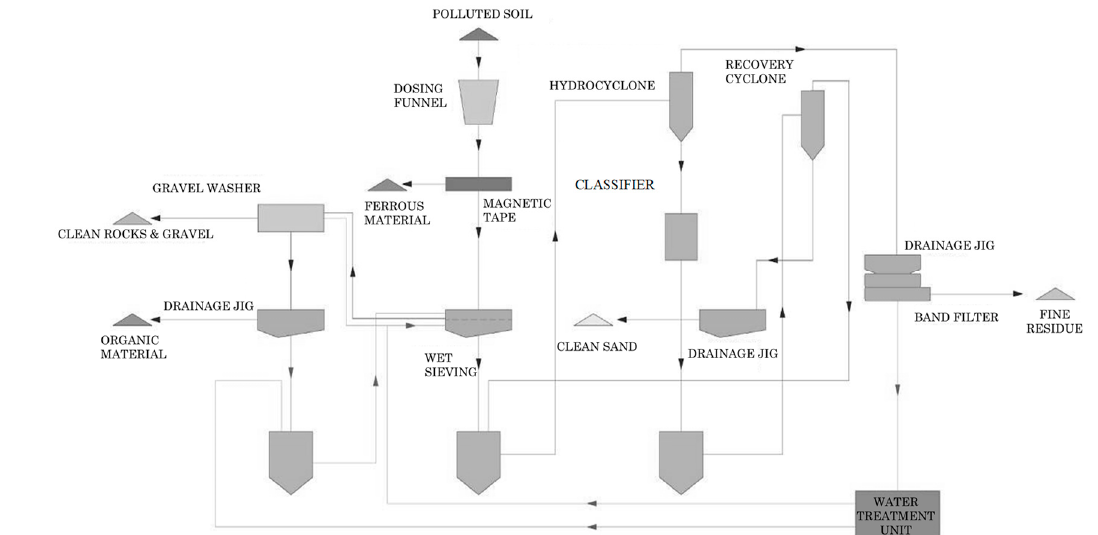
Figure 1. Scheme of a mobile plant of soil washing (Courtesy of Soldec Tecnologías